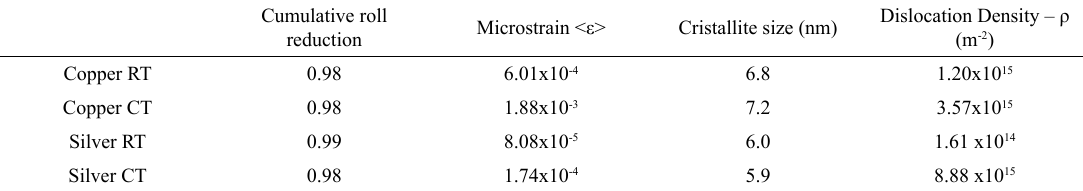
Table 4. Parameters obtained from X-ray diffraction of samples of copper and silver rolled at room and cryogenic